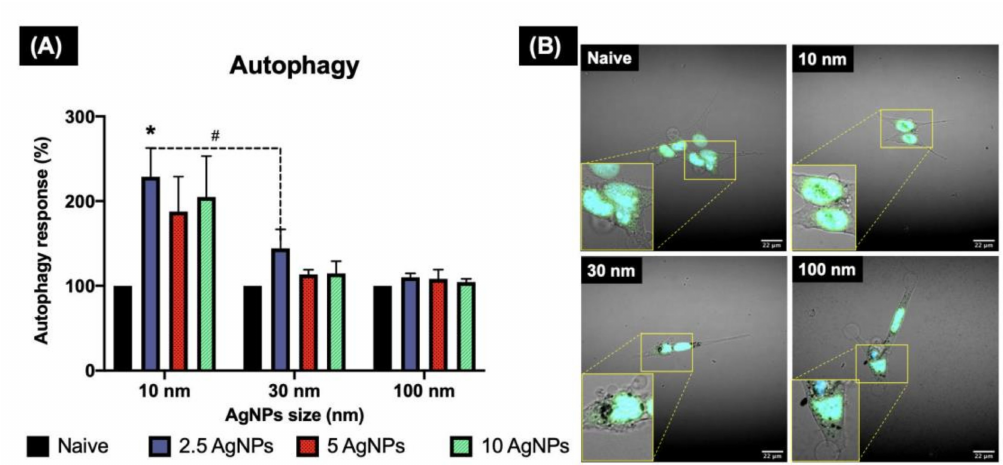
Figure 7. Autophagy induction in ZF4 cells exposed to AgNPs as determined by confocal microscopy. ZF4 Cells were treated with 2.5, 5, and 10 µ g/mL AgNPs of three different sized AgNPs (10, 30, and 100 nm) for 24 h. Images of the cells with the nucleus (blue) and autophagosome staining (green) were taken at 60 × with a NIKON A1R 808 series microscope (Nikon, Tokyo, Japan). A close-up of the labelled cells is marked with yellow lines. The intensity of the labelled autophagosomes in ZF4 cells was recorded by FIJI. ( A ) Results of three individual replicates are expressed as mean and standard deviation (Mean ± SD). A statistical comparison between all the treatments was performed. Data with asterisks (*) indicate a statistical difference (* p < 0.05) between the treatments compared to the untreated control (naive). The symbol above the bars (#) represents a statistically significant difference (# p < 0.05) between the marked treatments. ( B ) Cells treated with 10 µ g/mL of different AgNPs sizes and the control. Images for the remaining AgNP concentrations and sizes can be found in the Supplementary Materials (Figure